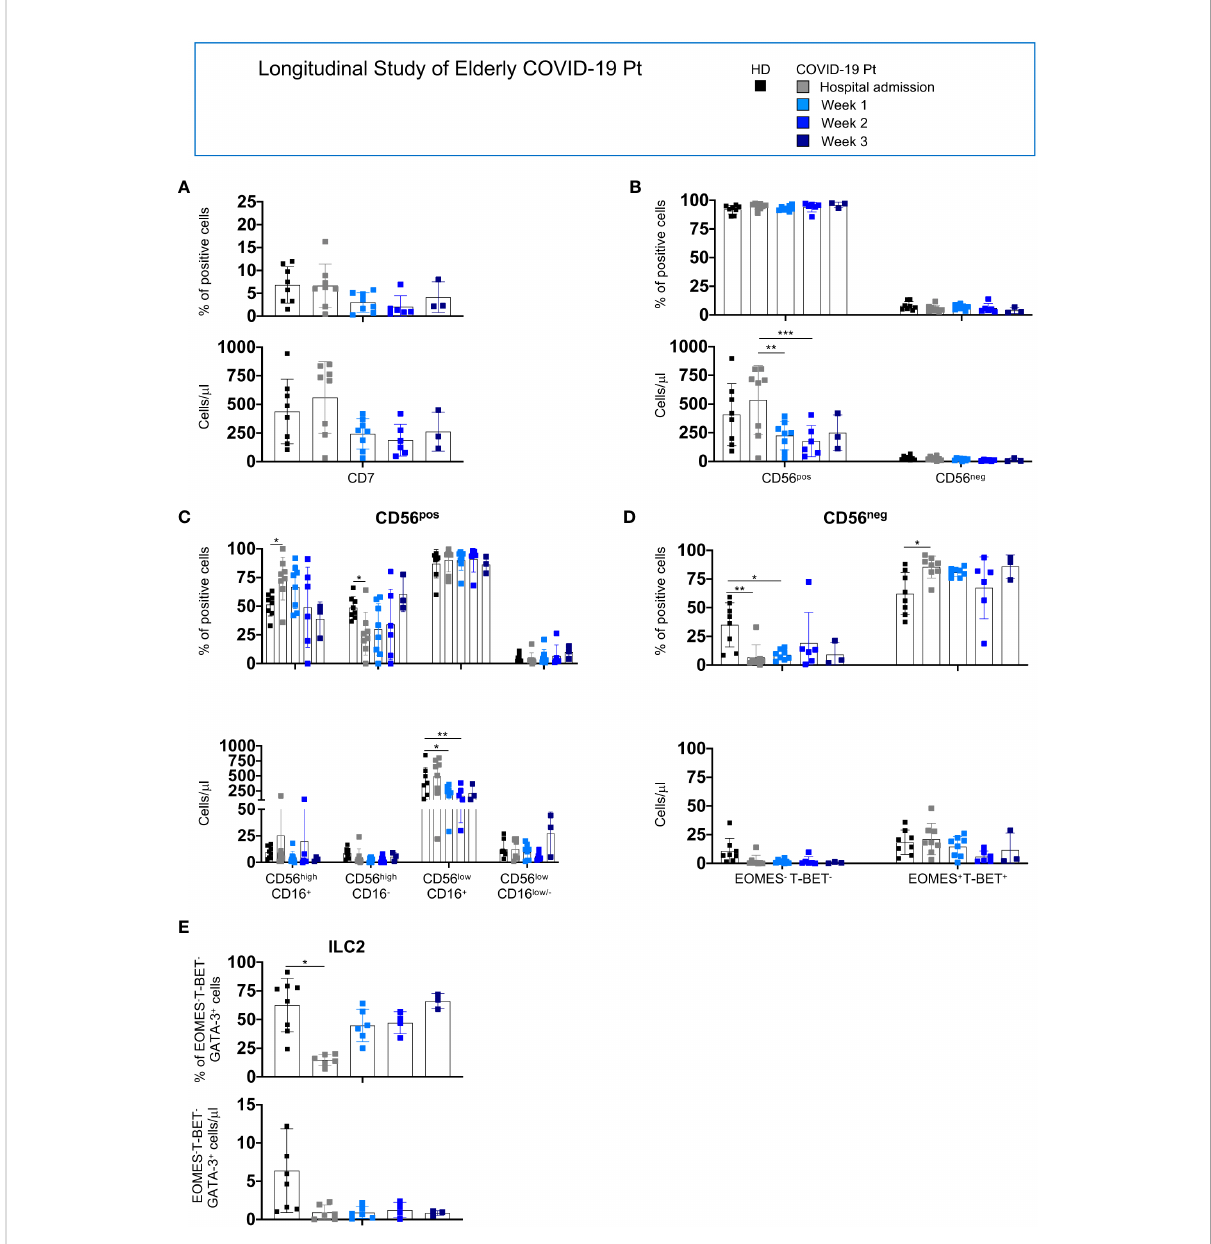
FIGURE 6 Longitudinal analysis of NK/ILC populations in elderly COVID-19 patients. Histograms represent the mean ± SD of the frequency and the absolute count of CD7 + (A) , CD56 pos and CD56 neg (B) , CD56 high (C) CD56 low (D) and ILC2 (E) in elderly patients at the indicated period. Cell populations were gated as described above. Elderly patients: hospital admission n = 8; week 1 n = 8; week 2 n = 6; week 3 n = 3. * p< 0.05, ** p< 0.01, *** p< 0.001. Two-way analysis of variance (ANOVA) Tukey ’ s multiple comparisons test and One way ANOVA Kruskal-Wallies test multiple